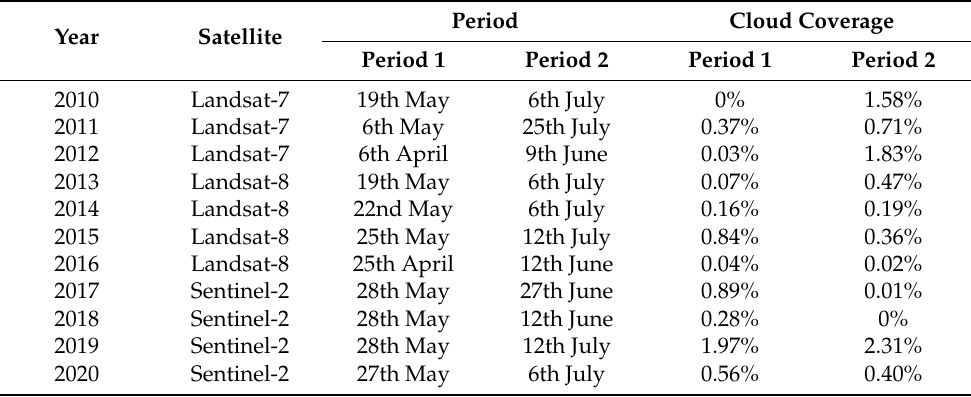
Table 1. Acquisition dates and cloud coverage of the remote sensing